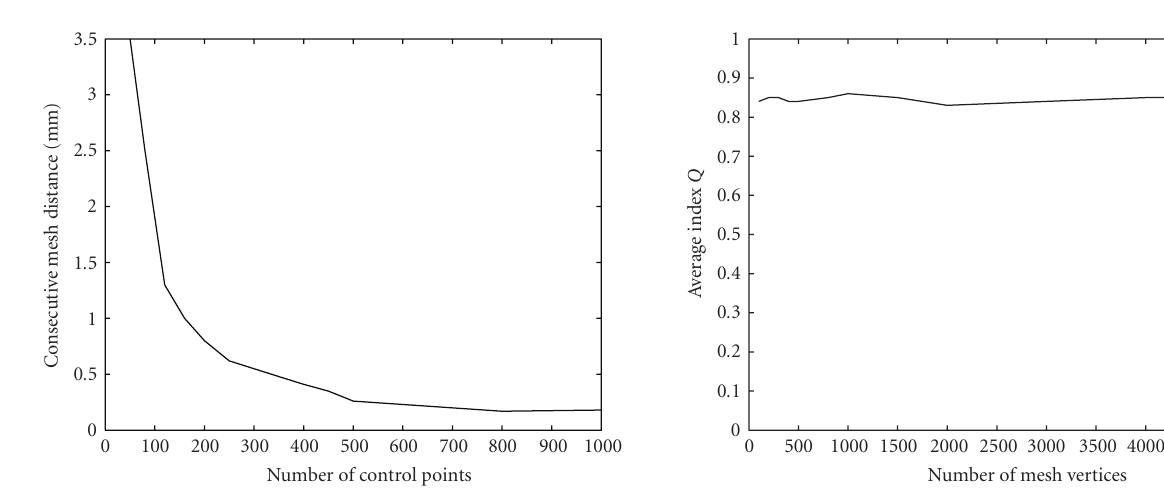
Figure 6: Average triangle quality index as a function of the number of mesh vertices. Table 1: The average in-slice distance ( D ) between the surface meshes generated by the marching cubes and the proposed method is given for each mesh. The in-plane resolution was 1.44mm × 1.44 mm. The numbers of singularities ( M ), control points ( K ), and mesh vertices ( V ) used to generate the meshes with the proposed method are also reported.